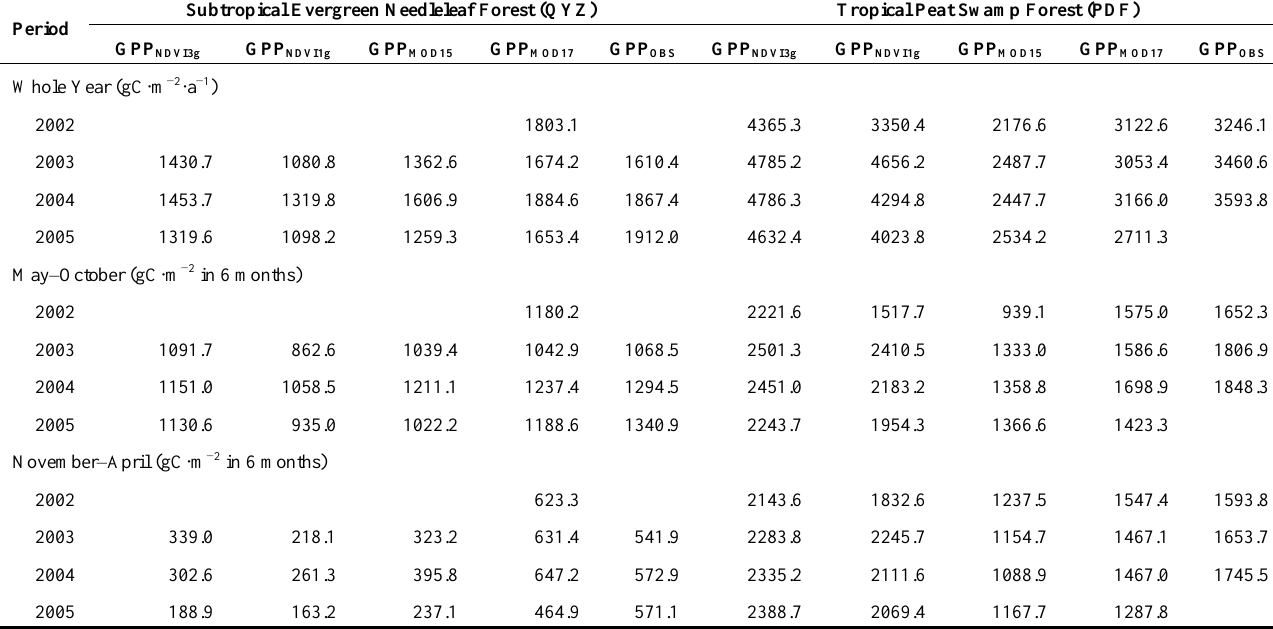
Table 2. The statistics of the modelled and observed GPPs from eddy covariance flux towers at annual and seasonal scales (May–October, November–April) in the evergreen needle-leaf forest at Qianyanzhou (QYZ), Jiangxi province, China and the tropical peat swamp forest at Palangkaraya (PDF), Indonesia. GPP the GPP results derived using the GLOPEM-CEVSA model and the GIMMS NDVI3g, GIMMS NDVI and MOD15A2, respectively. GPP MODIS GPP product MOD17A2 and the observed